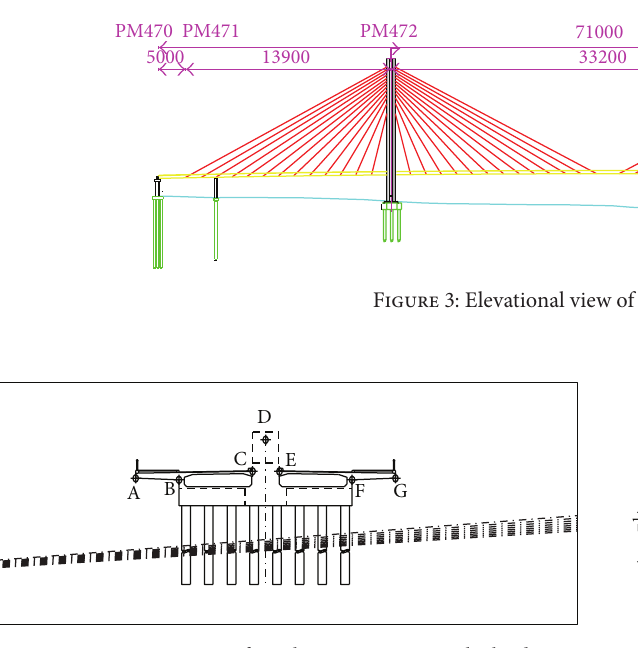
Figure 4: Arrangement of acceleration sensor on the bridge.